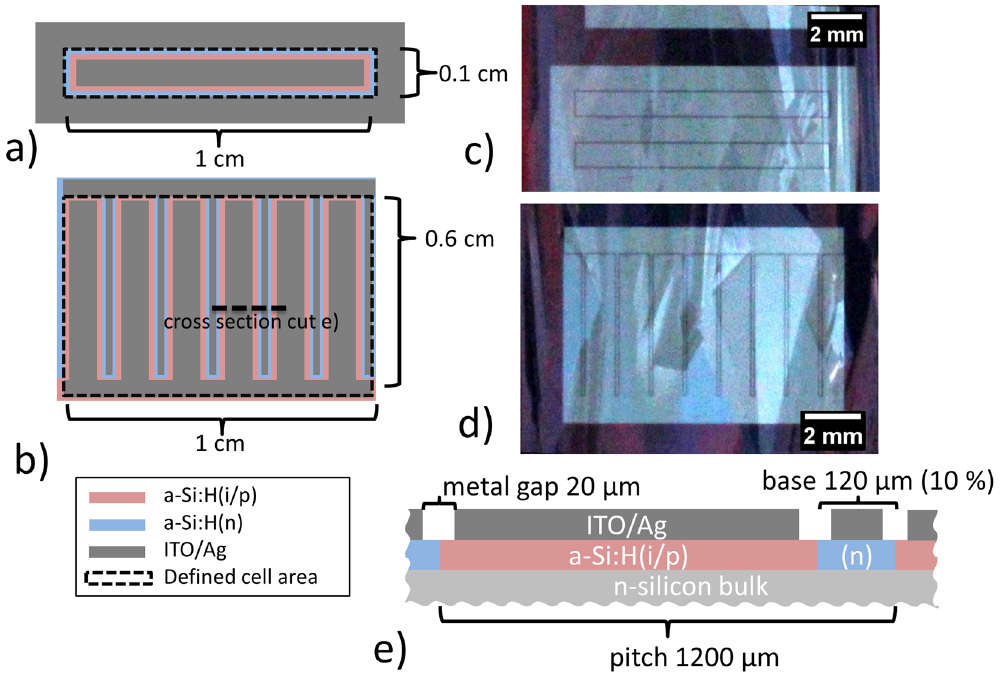
Figure 1. Top view from the back side of ( a ) full-emitter-cell (FEC) structure and ( b ) IBC cell. Photograph of two FEC structures ( c ) and one IBC cell ( d ) on glass from the LPC-Si layer/contact system side. ( e ) cross section of IBC cell as marked by dashed line in ( b ).